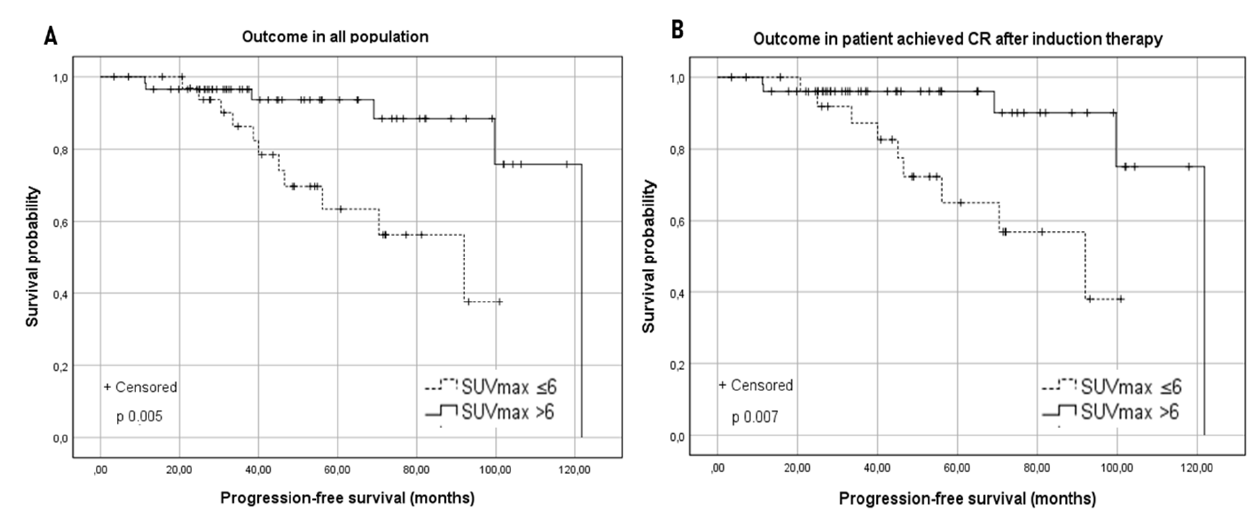
Figure 1. ( A ) Kaplan–Meier survival curves for the progression-free survival (PFS) in the studied population according to the baseline SUV max with a cut-off of 6. ( B ) Kaplan–Meier survival curves for the progression-free survival (PFS) according to the baseline SUV max in patients who achieved a complete response (CR) after induction therapy.